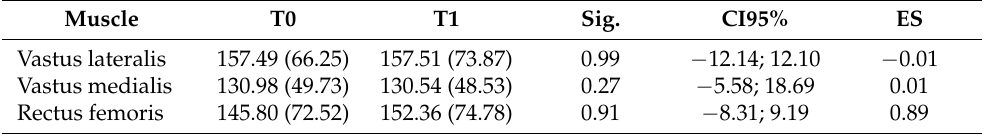
Table 2. Means (standard deviations) of and changes in physical measurements evaluated in both assessments in root mean square.